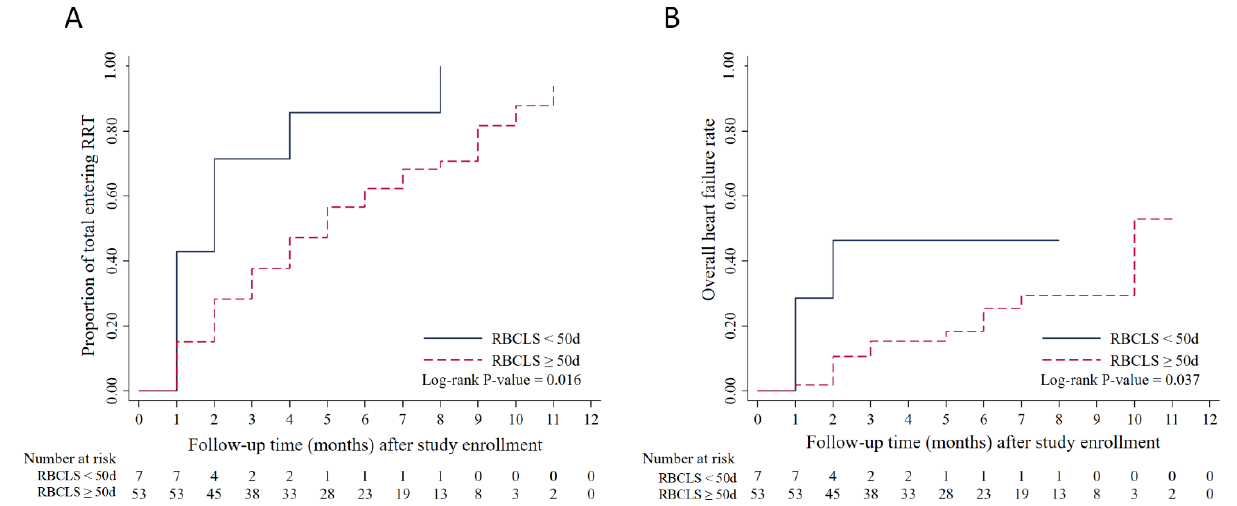
Figure 3. Kaplan – Meier curves for time to renal replacement therapy and heart failure in patients with different RBCLS. ( A ) Kaplan – Meier curves for time to renal replacement therapy in patients with different RBCLS. ( B ) Kaplan – Meier curves for time to heart failure in patients with different RBCLS.